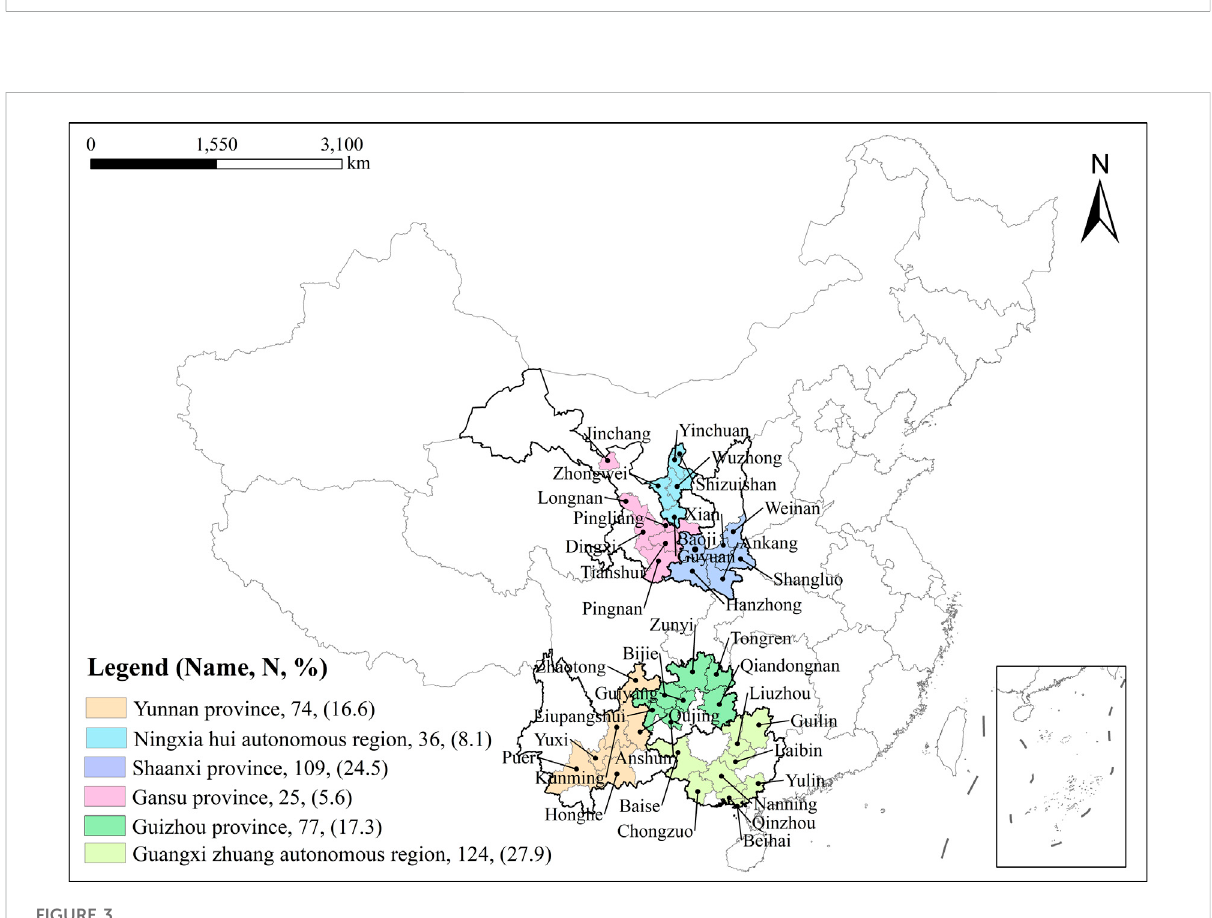
FIGURE 3 Geographical and quantitative distribution of